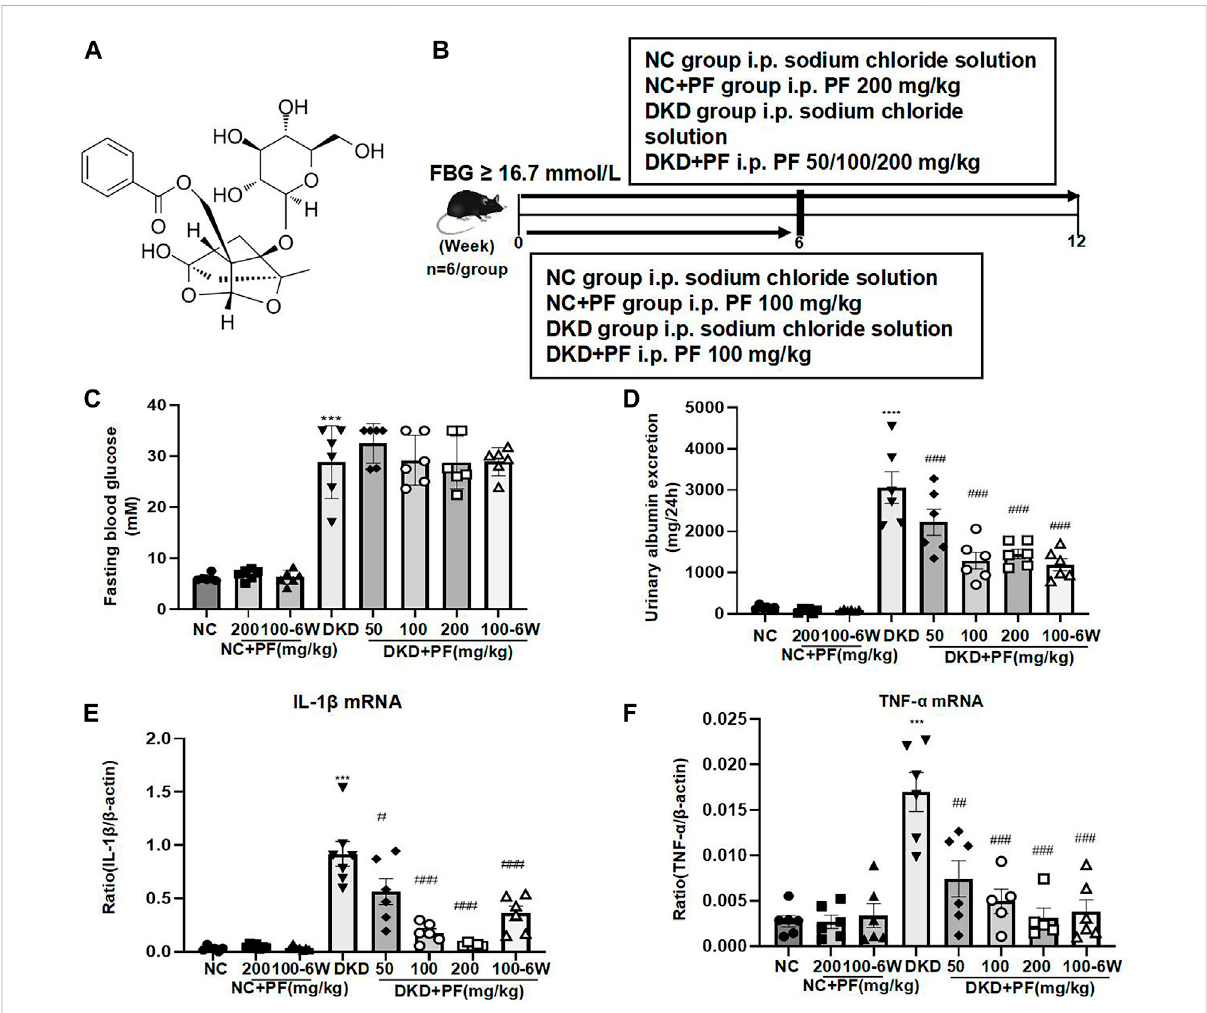
FIGURE 2 Serum and urine biochemical parameters of STZ-induced diabetic mice. (A) Molecular structure of PF. (B) Study design of the animal experiment and treatment. (C) Fasting blood glucose in different groups. (D) A 24 h urine albumin excretion in different groups. (E) IL-1 β mRNA in differentgroups. (F) TNF- α mRNAindifferentgroups.Resultsrepresentthemean±SDfor6mouse/group.*** p < 0.001vs.NC; # p < 0.05, ## p < 0.01, ### p < 0.001vs.DKD.FBG,fastingbloodglucose;NC,normalcontrol;DKD,diabetickidneydisease;PF,paeoni fl orin;STZ,streptozotocin;TNF- α , tumor necrosis factor- α